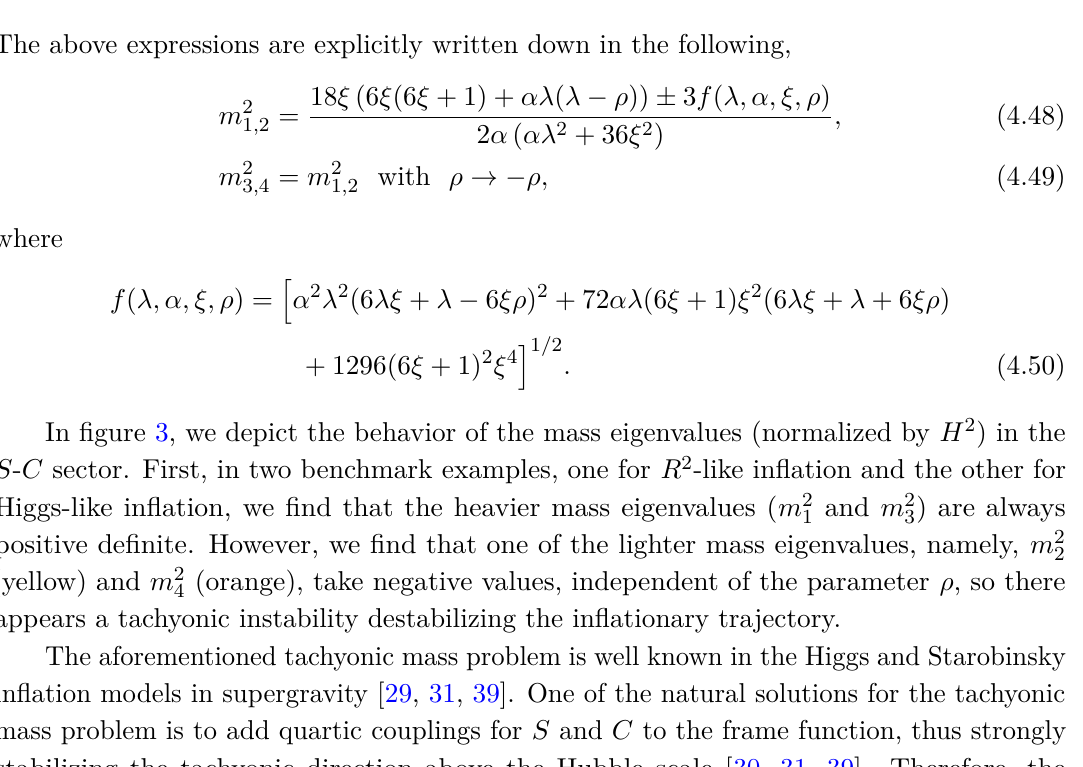
Figure 3 . The squared mass eigenvalues for the lighter states of singlet scalars, S and C , as a function of the singlet self-coupling ρ : m 2 ( λ, ξ, α ) = (0 . 5 , 10 4 , 10 10 ) for R 2 -like inflation on left and ( λ, ξ, α ) = (4 × 10 − 5 , 1 , 10 2 ) for Higgs-like inflation on